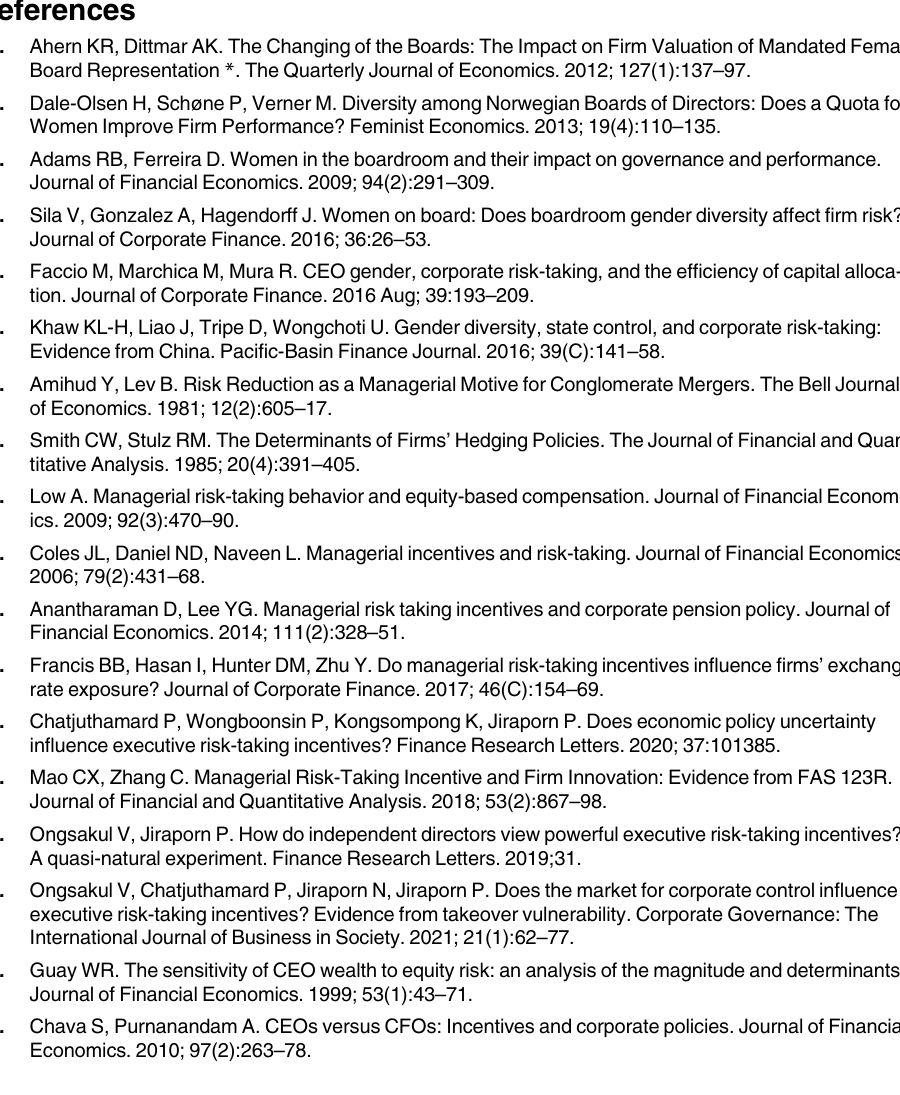
S3 Table. Summary statistics before and after entropy